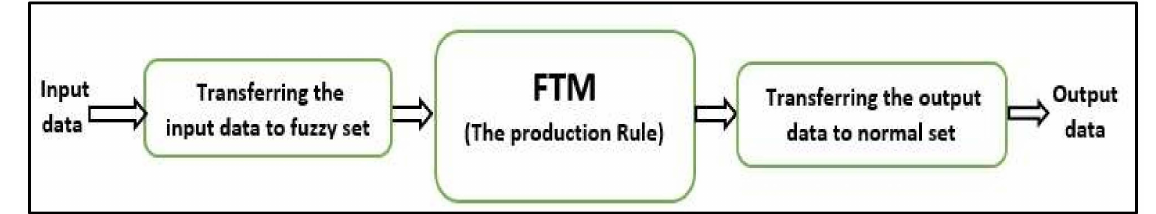
Figure 6. Flowchart presents how the model (FPM) predicts new results.